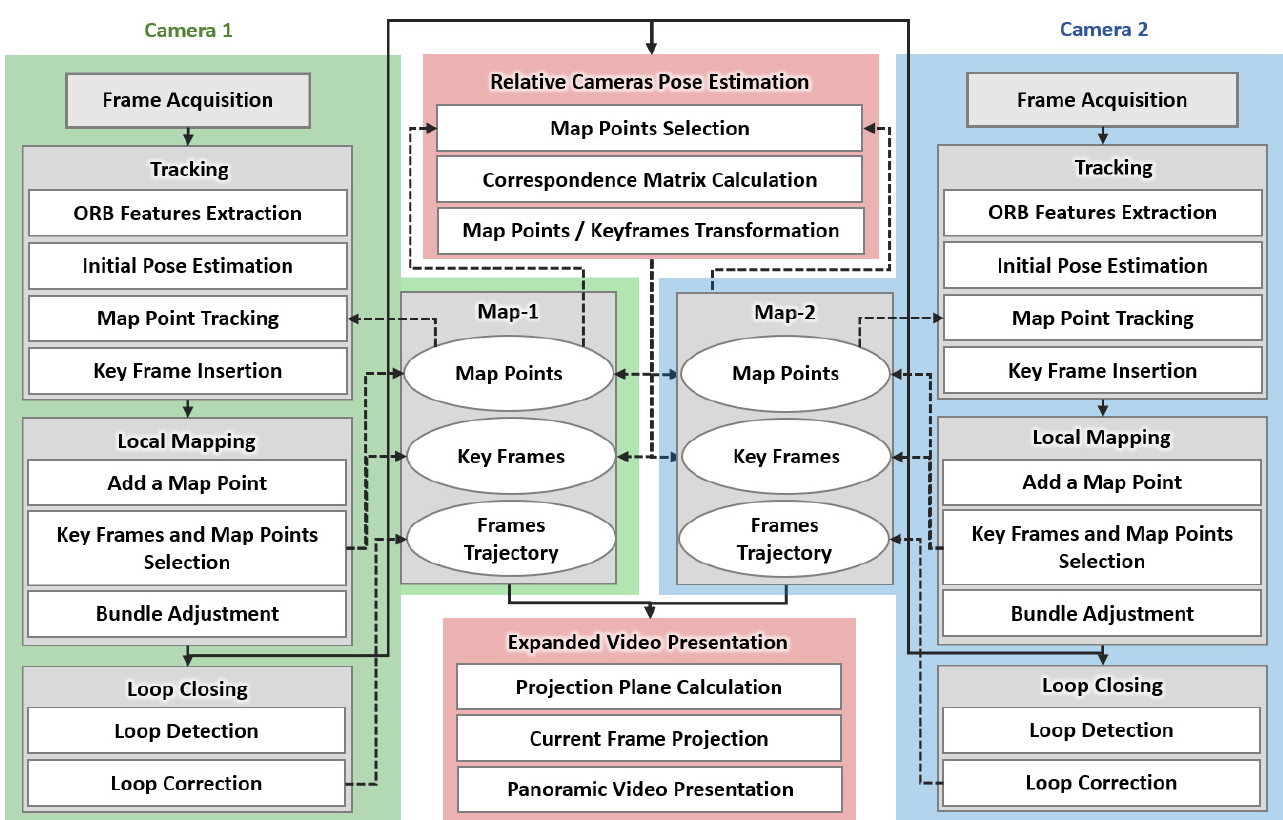
Figure 2. The pipeline of the proposed approach: three threads of Visual Simultaneous Localization and Mapping (vSLAM) for each camera, one thread for calculating the transformation between cameras and one for constructing the expanded